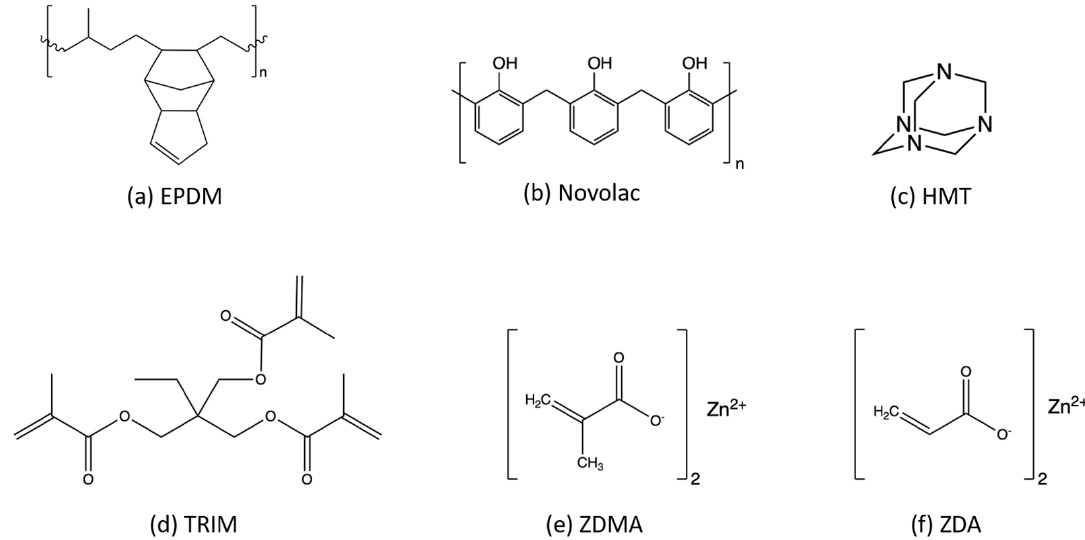
Figure 1. Molecular structures of applied chemicals.